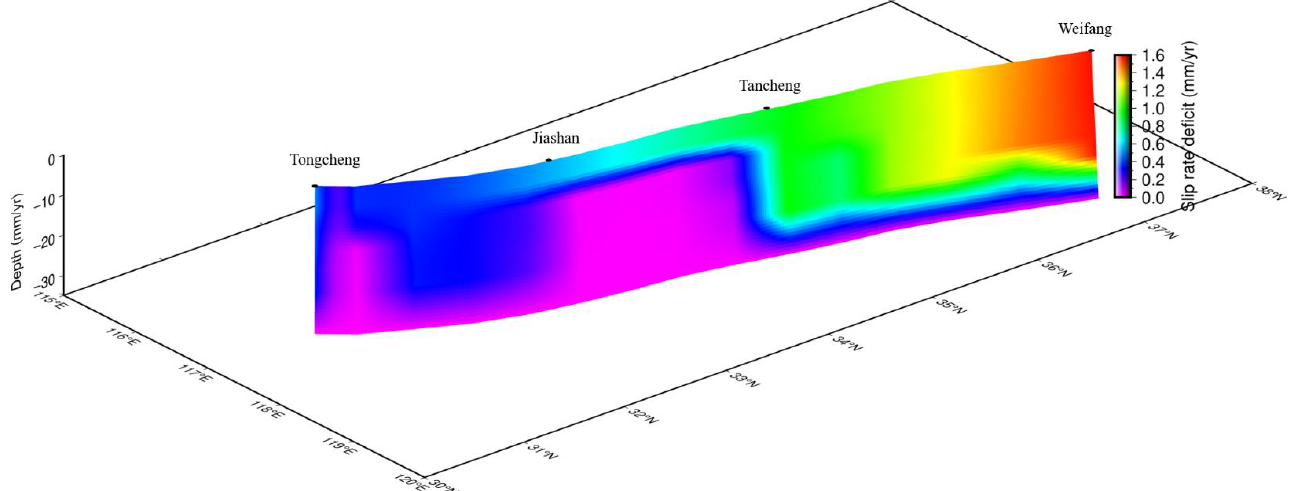
Figure 5. The 3D spatial distribution of slip rate deficit of the optimal model inverted by AHCORS and CMONOC velocity field (mm/a). Purple to red indicates the slip rate deficit. The red places indicate the slip rate deficit is large, and the purple places mean that there is no slip rate deficit.